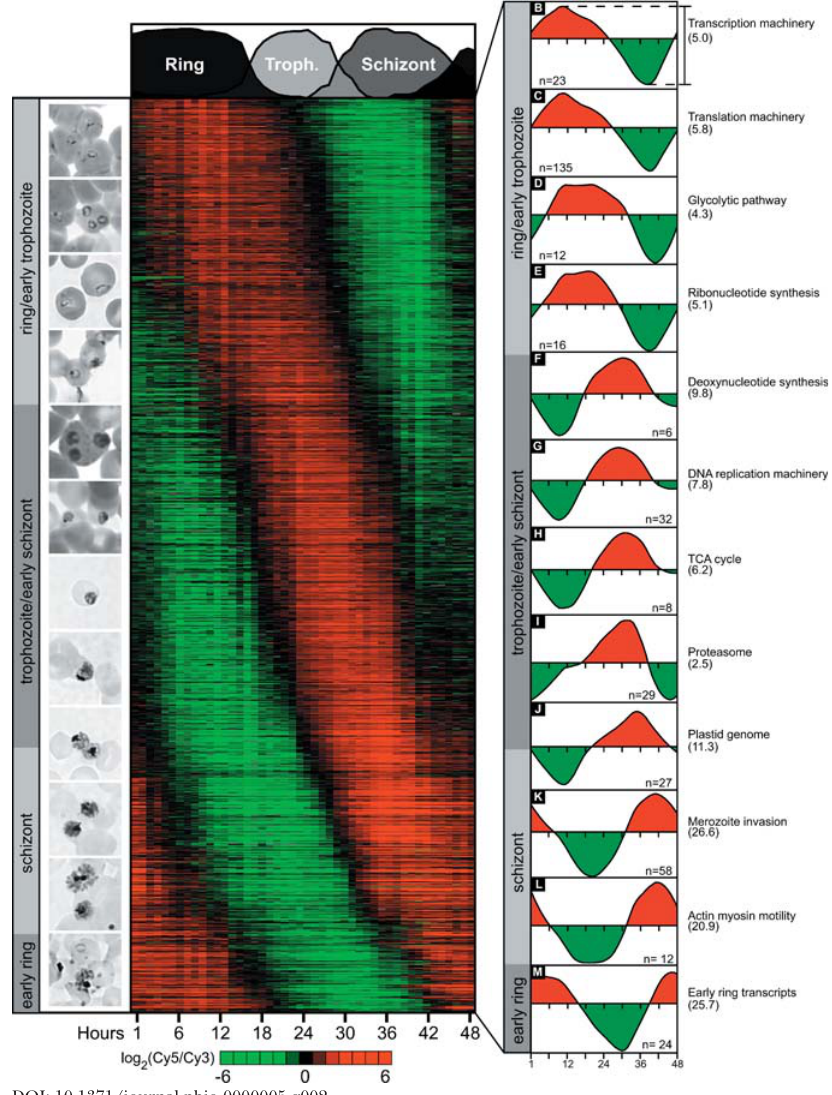
Figure 2. Example of Student’s Data Mining for Exam Question Figure 2 from Bozdech et al. (2003) showing the gene expression profi les for 12 groups of genes expressed at different stages of Plasmodium life cycle inside red blood cells. Genomics students were asked to summarize this fi gure as a part of a take-home